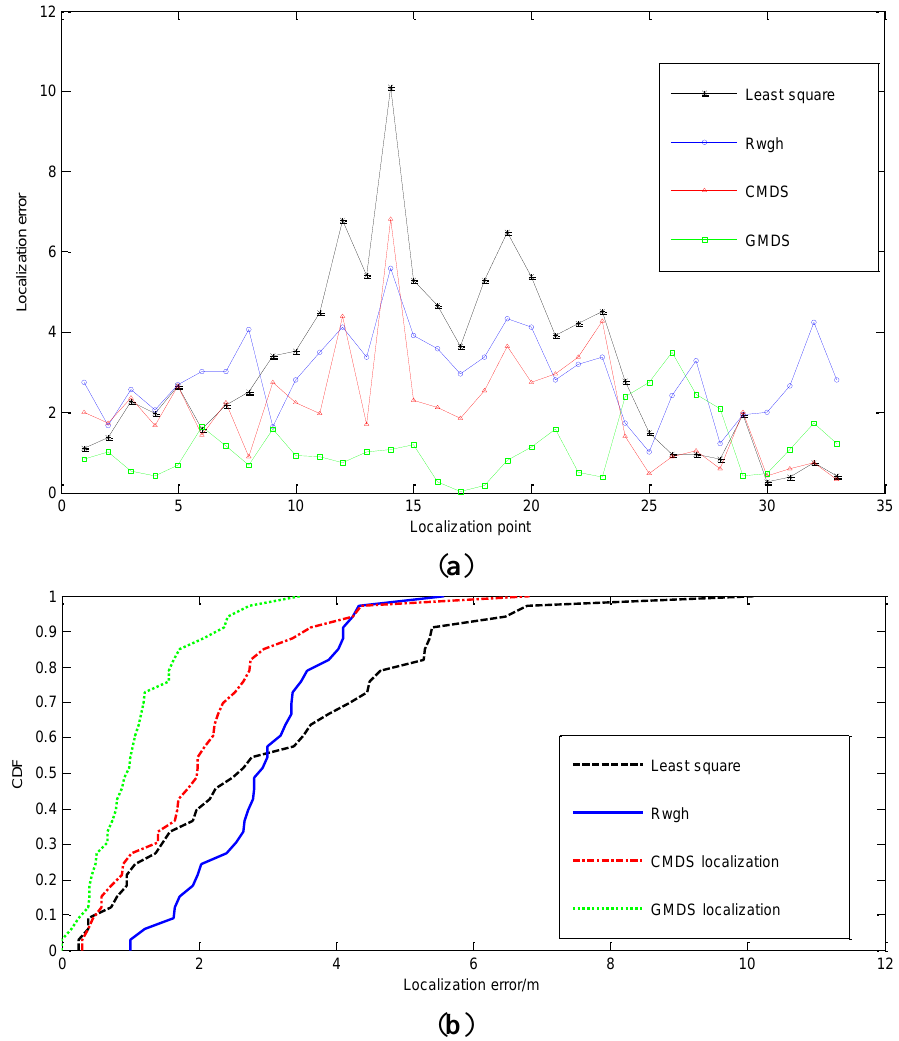
N  . ( a ) Localization error when nlos N  . nlos